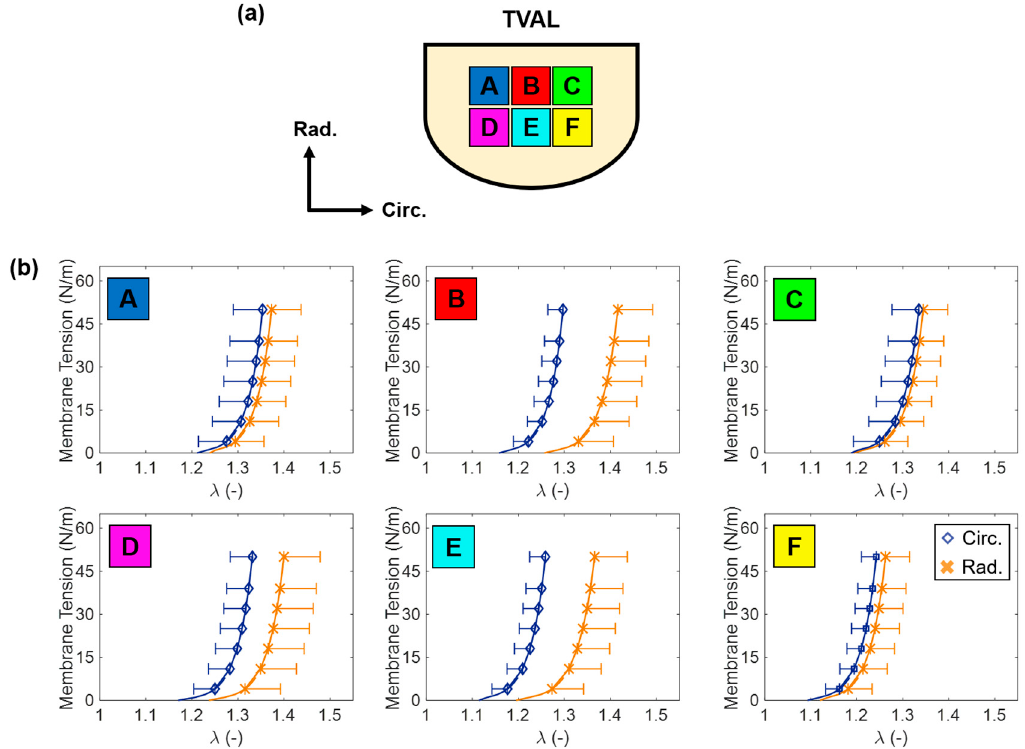
Figure 9. ( a ) Schematic of the TVAL with six smaller tested regions for investigating the regional variance in the tissue’s mechanical properties. ( b ) Mean ± SEM (n = 10~13) of membrane tension versus total tissue stretch results for the 6 tissue regions under the equibiaxial loading protocol. Images were modified from Laurence et al. (2019) [125].